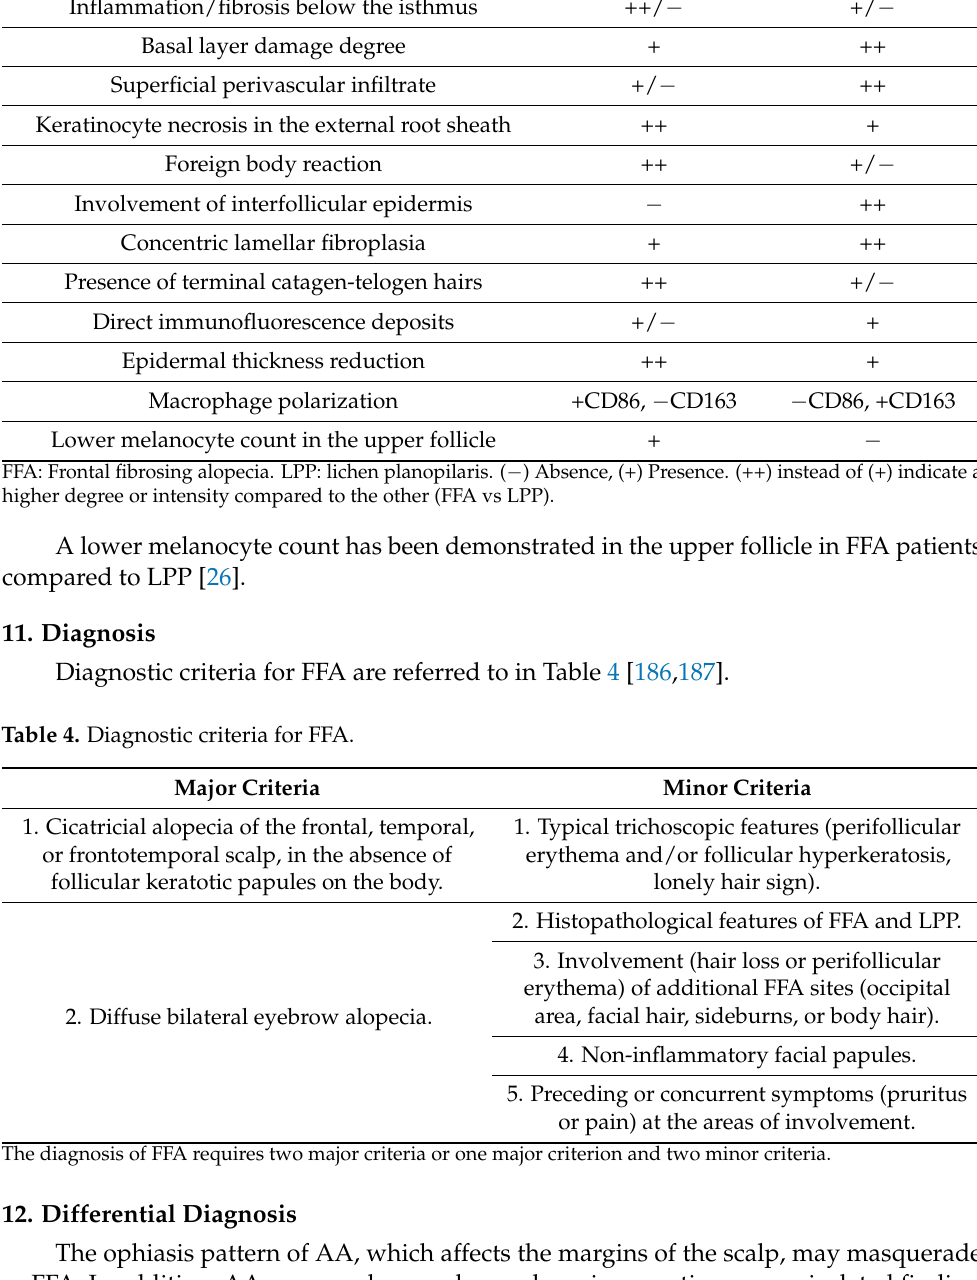
Table 3. Histopathological differences between FFA and LPP.